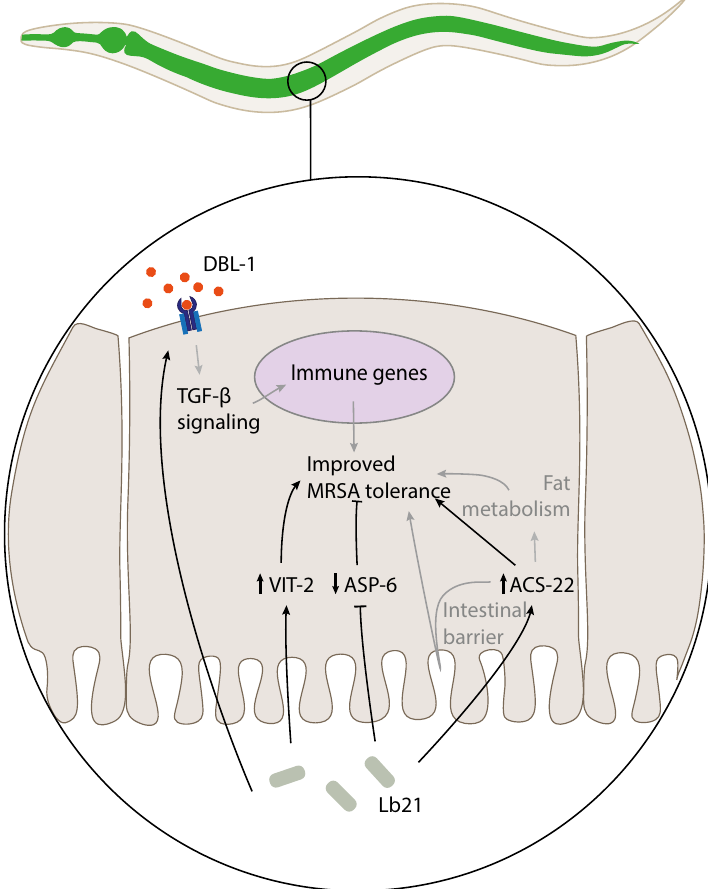
Figure 7. Lb21 affects C. elegans in a multifaceted manner. The protection against MRSA mediated by Lb21 is dependent on DBL-1 and the effect could likely be mediated by TGF-β controlled immune genes. MRSA tolerance is also dependent on ACS-22 and the underlying mechanism could be both improved intestinal barrier function and altered fat metabolism. VIT-2 and ASP-6 are also required for the protective effect of Lb21 towards MRSA infection. Black lines indicate interactions shown in this study and grey lines indicate possible mechanisms of action based on published